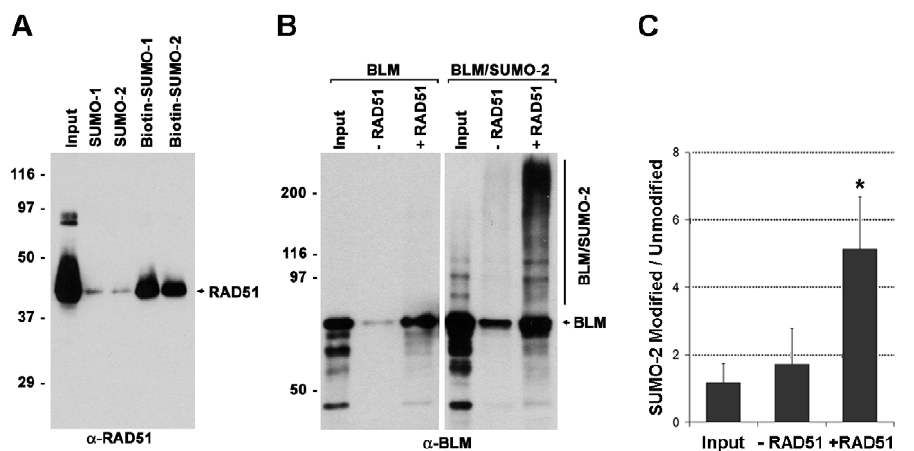
Figure 6. RAD51 contains a SUMO binding site. (A) Biotinylated SUMO-1 and SUMO-2 were bound to streptavidin beads and incubated with purified recombinant, human RAD51; the complexes were pulled down and analyzed by Western blot with anti-RAD51. As a control, unbiotinylated SUMO-1 and SUMO-2 were incubated with beads and incubated with RAD51. (B) A purified, recombinant N-terminal fragment of BLM, consisting of amino acids 1–431, was modified with SUMO-2 in vitro. Equal amounts of SUMOylated or unSUMOylated BLM were incubated with RAD51 bound to streptavidin beads, and complexes were pulled down and analyzed by Western blot with anti-BLM. As a control, SUMOylated or unSUMOylated BLM was incubated with unconjugated streptavidin beads. (C) Ratios of SUMO-2–modified BLM to unmodified BLM in input fraction and fractions bound to control beads and beads containing RAD51. Experiment was performed three times. * p =0.03, RAD51-coated beads versus control beads. (Figure 2). For example, SM-BLM cells exhibited more HU- induced DSBs, which arise due to breakage of stalled forks, and